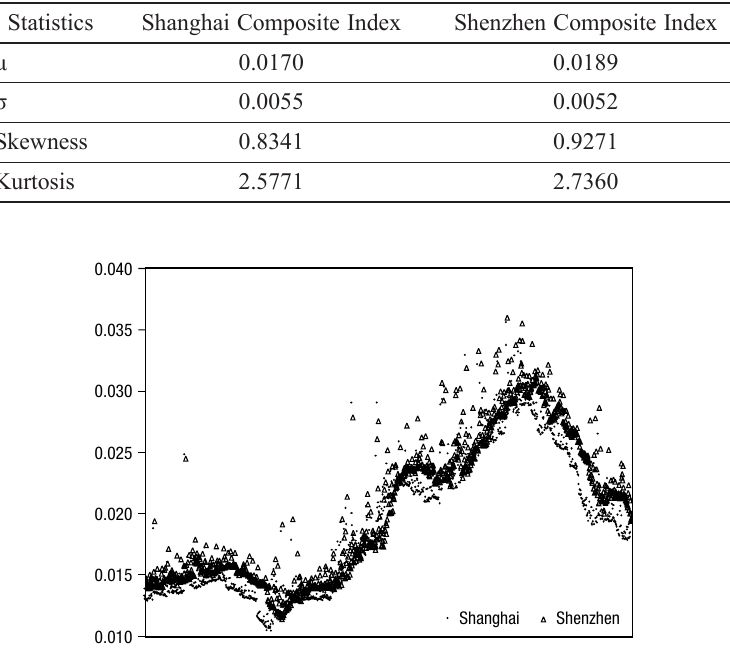
Fig. 2. The paths of the GARCH volatility of the